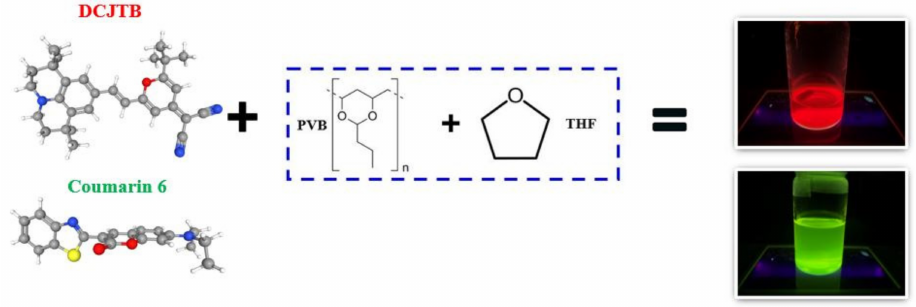
Figure 1. Schematic diagram of the formulation of the hybrid material for the red and green conversion